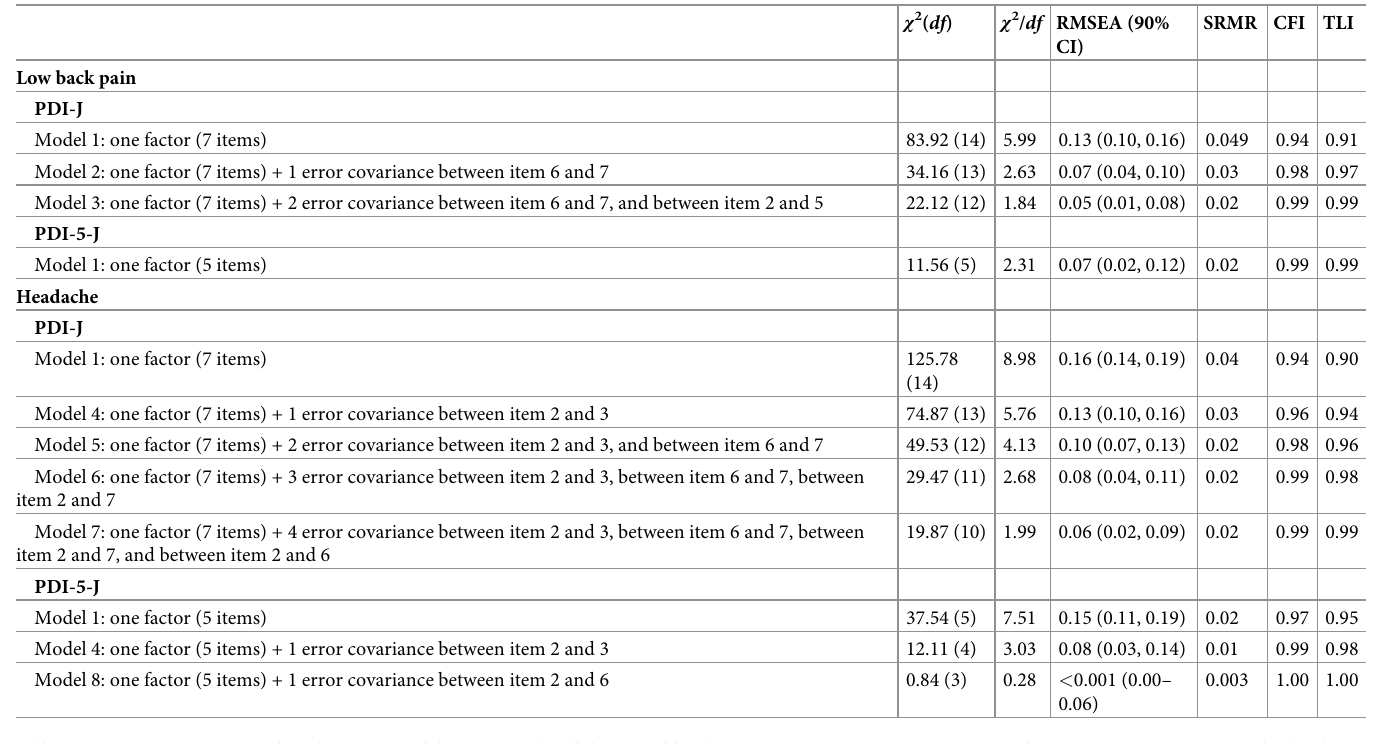
SRMR CFI TLI χ 2 ( df ) χ 2 / df RMSEA (90% CI)